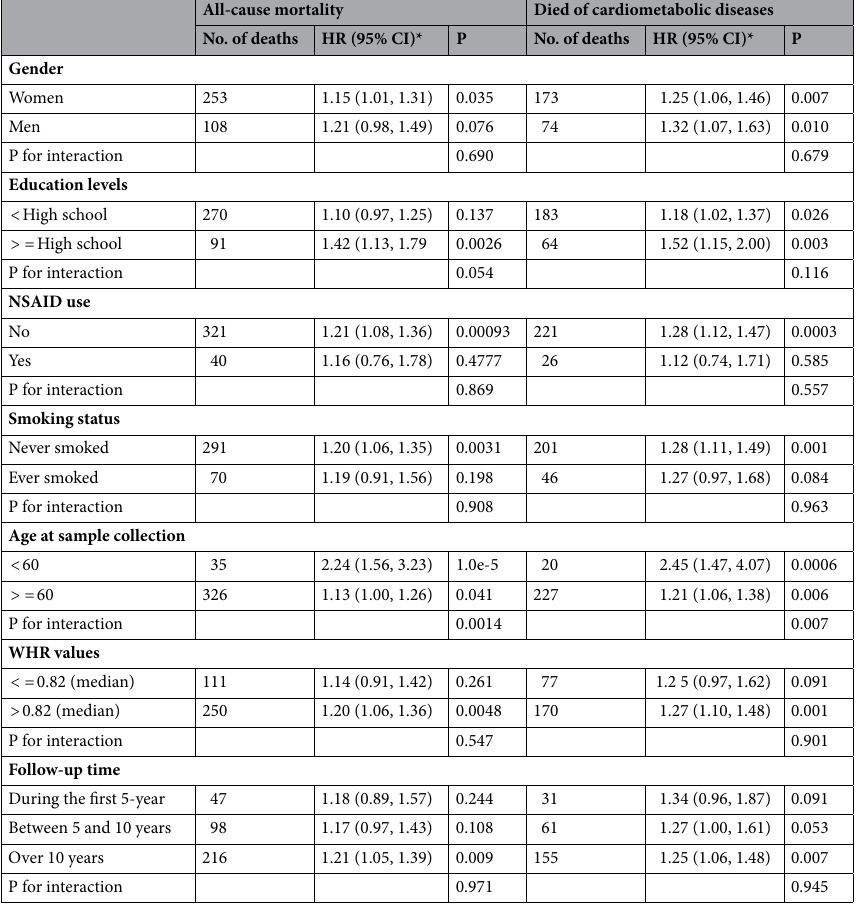
Table 3. Association between urinary PGE-M levels and death, stratified by selected covariables. *HRs and 95 CIs for continuous urinary PGE-M (log-transformed) were estimated for the increment by one standard deviation, with adjustment for covariates in Table